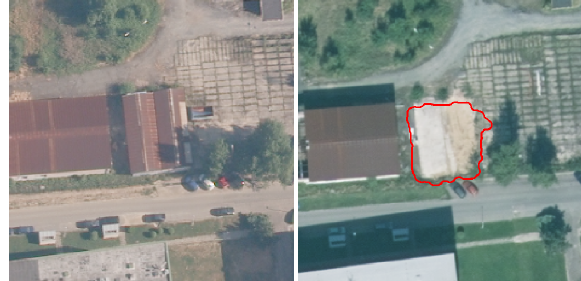
Figure 17. Left: aerial image (2010) Right: aerial image (2012)